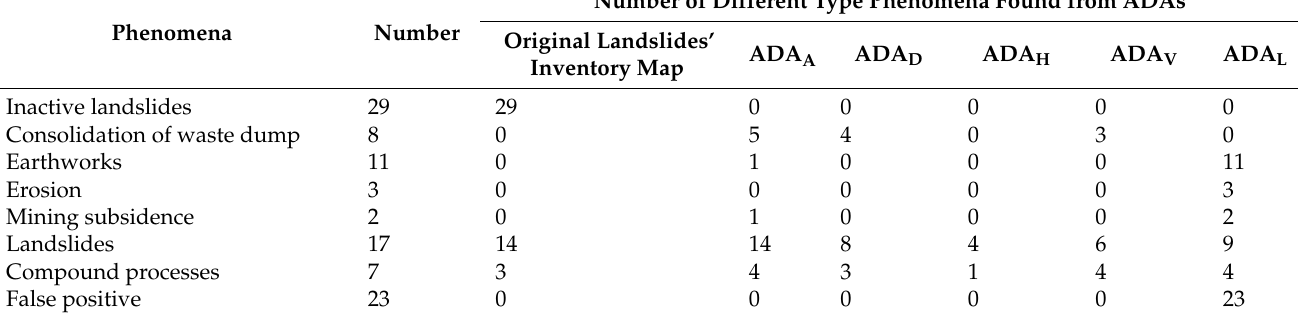
Table 4. Statistical distribution of the type of phenomena causing displacements.